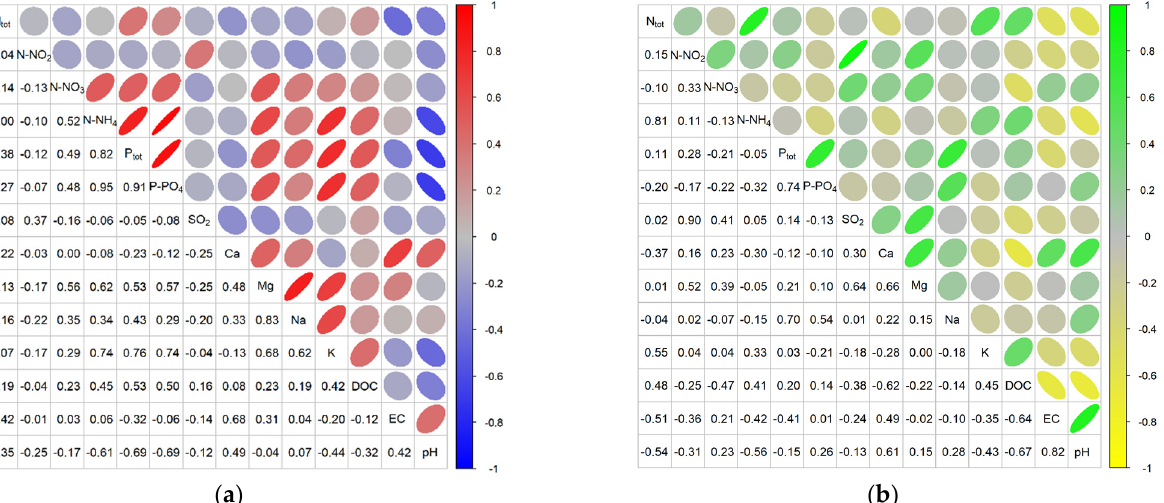
Figure 6. Correlations between physicochemical factors of peatland water as pooled data for Comarum palustre in 2011–2013: ( a ) abundant sites, ( b ) non-abundant sites. Ellipse angulation and color intensity are proportional to the Pearson correlation coefficient: positive correlations are shown in red/green and negative correlations in blue/yellow.